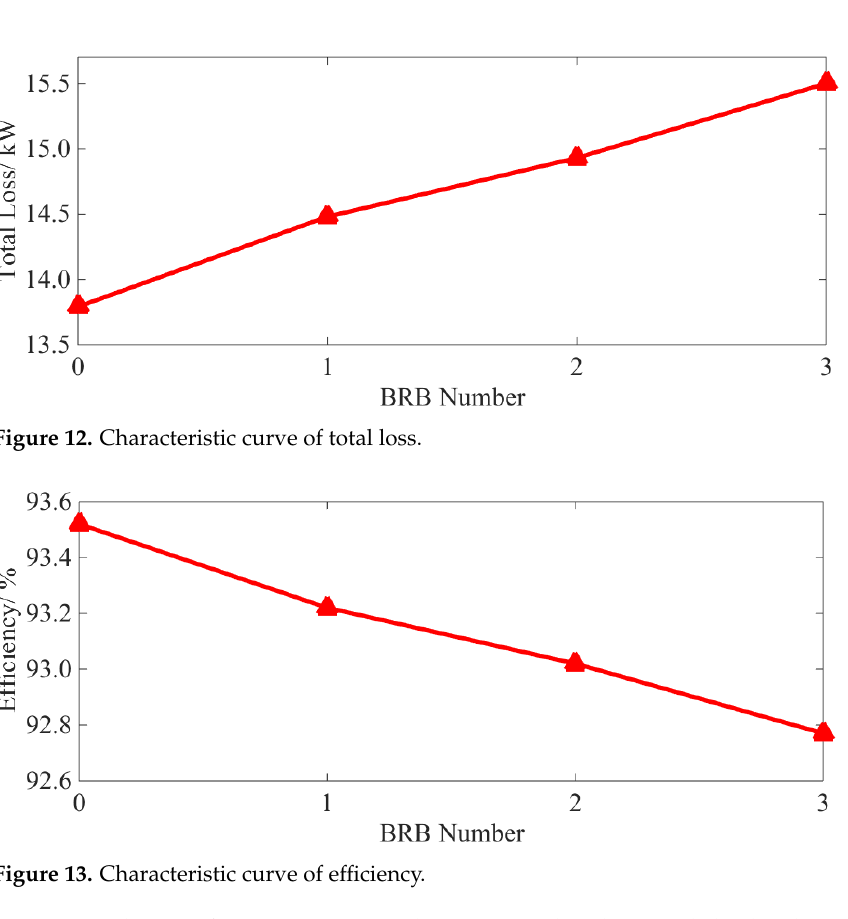
Table 2. Nameplate parameters of the experimental squirrel-cage